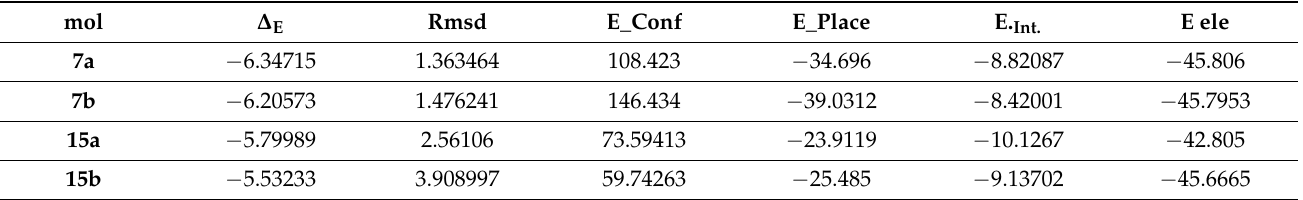
Table 4. Docking energy scores (kcal/mol) derived from the MOE for ligands ( 7a , 7b , 15a and 15b ).